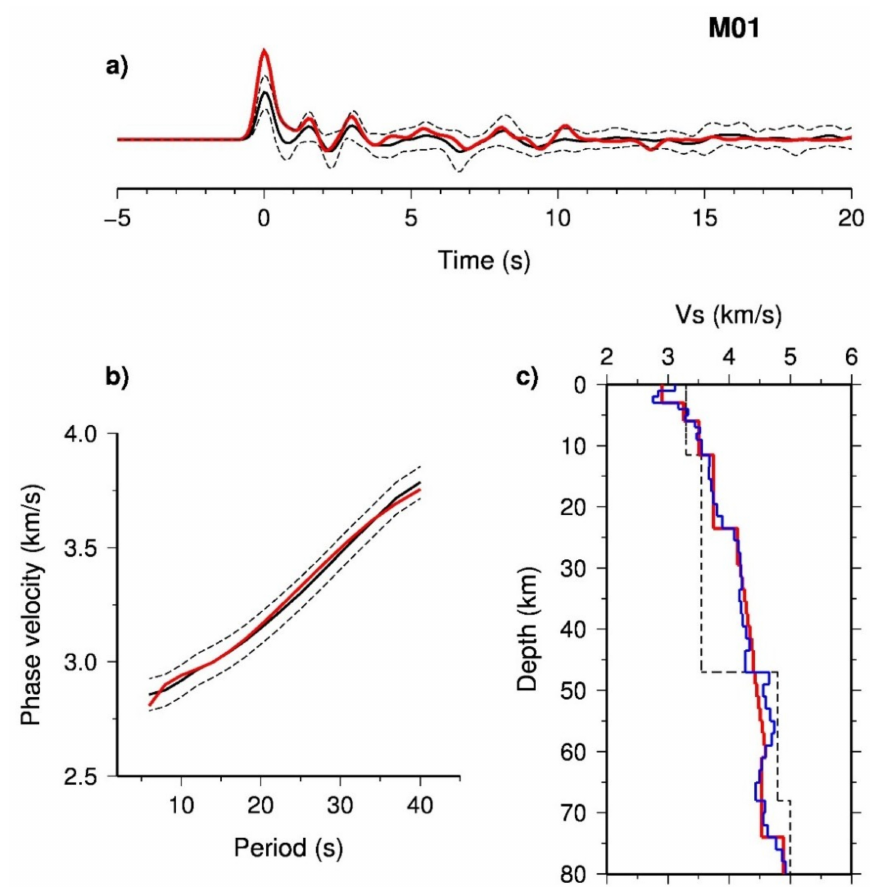
Figure 6. Seismic data inversion for the velocity model. ( a ) Observed stacked receiver function (black line) with its error bar (black dashed lines) and synthetic (red line) receiver function computed for the simplified crustal model shown by the red line in ( c ). ( b ) Observed (solid black line) phase velocity with its error bar (black dashed lines) and synthetic (red line) phase velocity computed for the simplified crustal model shown by the red line in ( c ). ( c ) Shear-wave velocity model obtained from joint inversion (solid blue line) and the simplified crustal model (solid red line), which is considered as the final model. The dashed line is the initial velocity